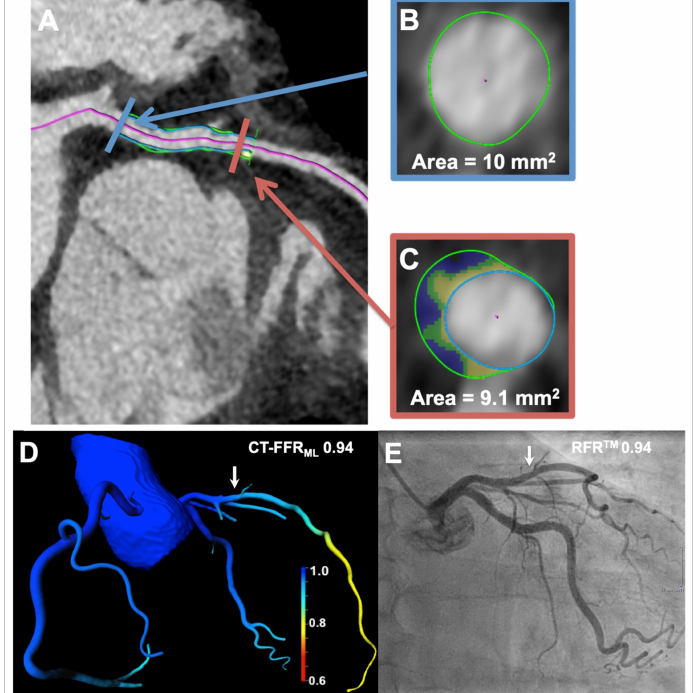
Figure 1. ( A ) The acquired cCTA shows non-relevant stenosis of the LAD with color-coded automated lesion quantification by the plaque tool. The mixed plaque in the LAD demonstrated a remodeling index of 0.91 and was calculated as ( C ) the target-lesion cross-sectional area (marked in